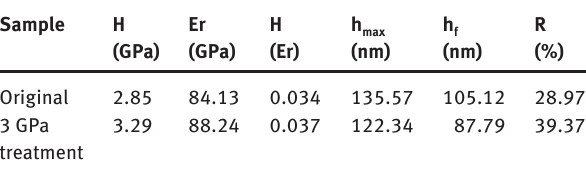
Table 1: Nanoindentation results of the CuZn alloy Sample